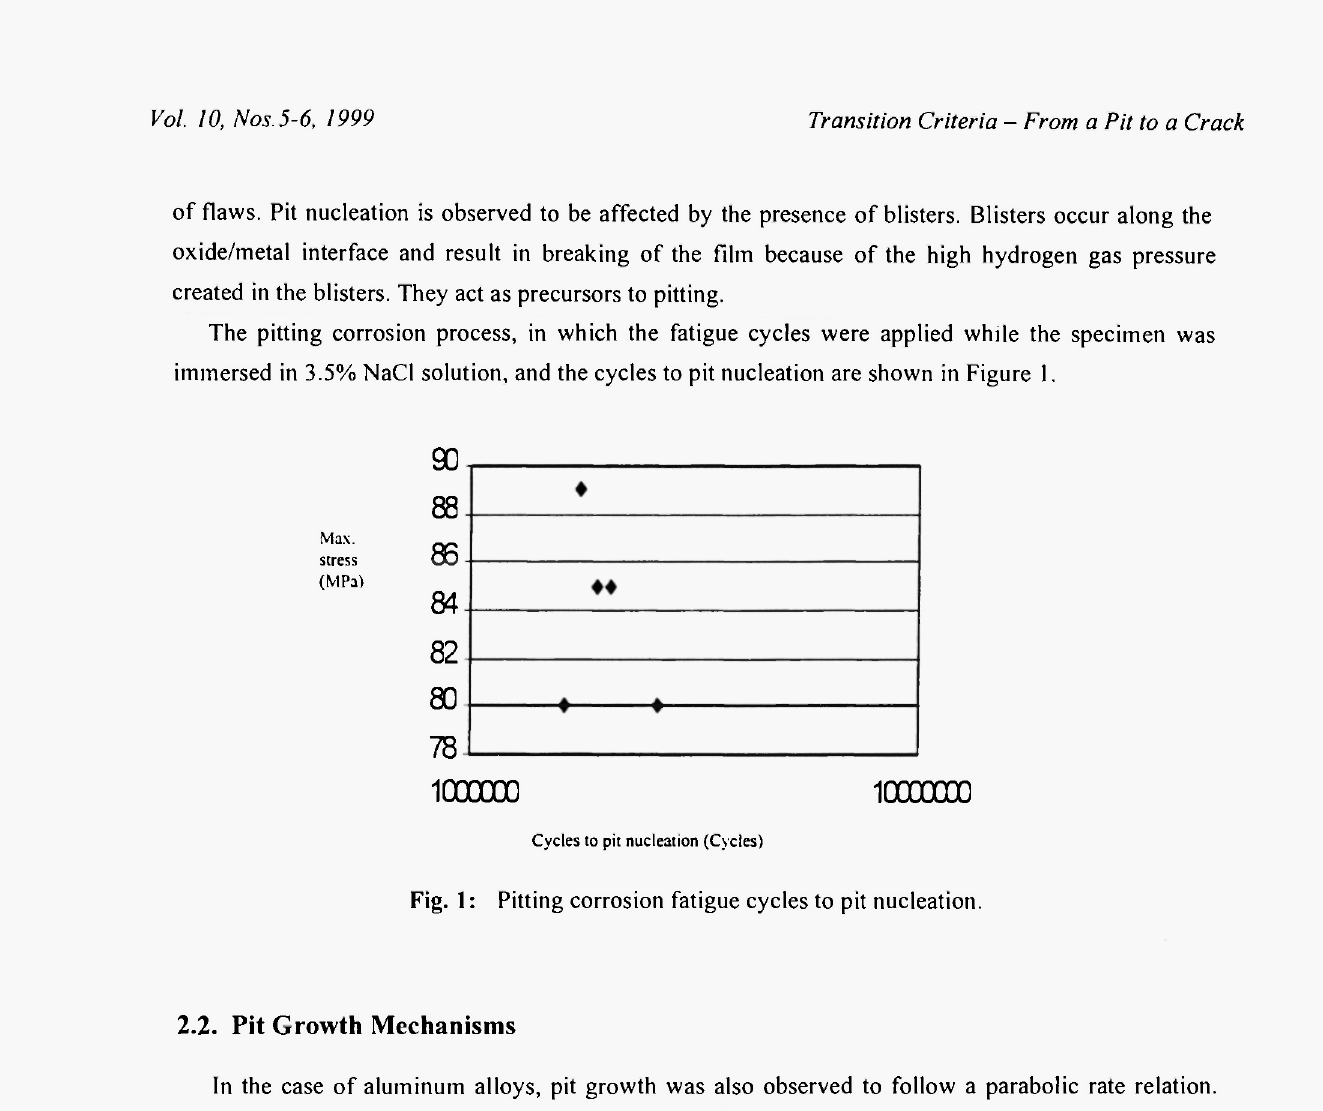
Fig. 1 : Pitting corrosion fatigue cycles to pit